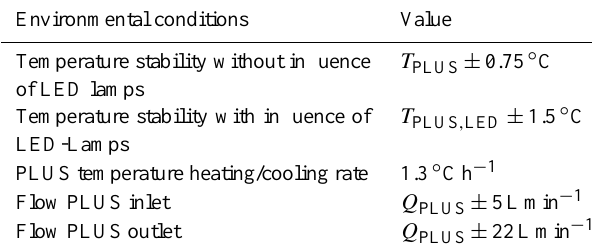
Table 1. Temperature and flow stability for typical operational con- ditions with T PLUS = 20 ◦ C and Q PLUS = 500Lmin − 1